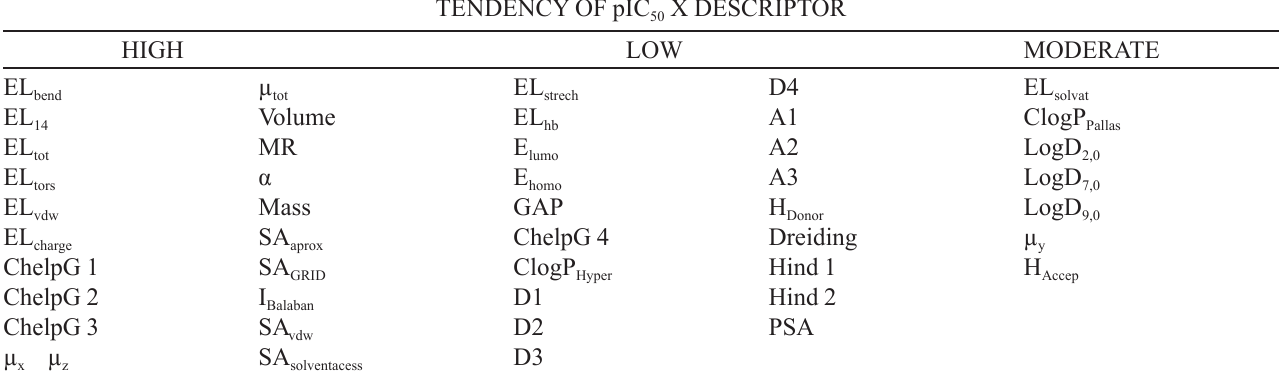
values 50 TENDENCY OF pIC X 50